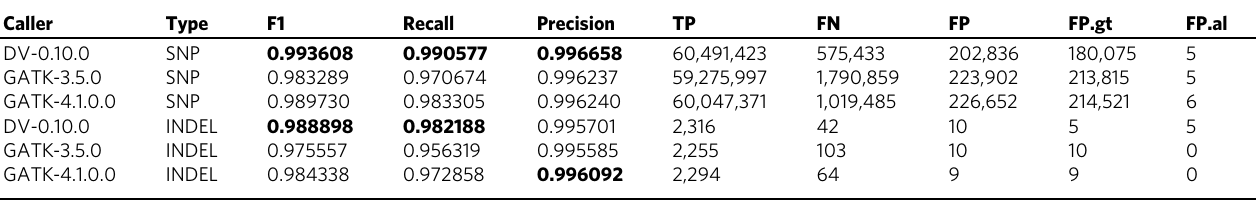
Table 1 Single-sample variant caller accuracy in 292 23andMe AFAM